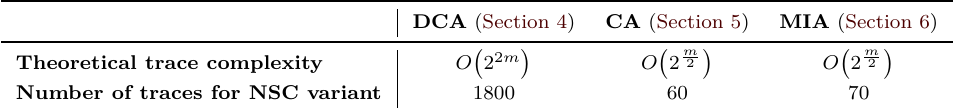
DCA (Section 4) CA (Section 5) MIA (Section 6) (cid:0) (cid:1) (cid:0) (cid:1) (cid:0) (cid:1) 2 2 m O 2 m 2 O 2 m 2